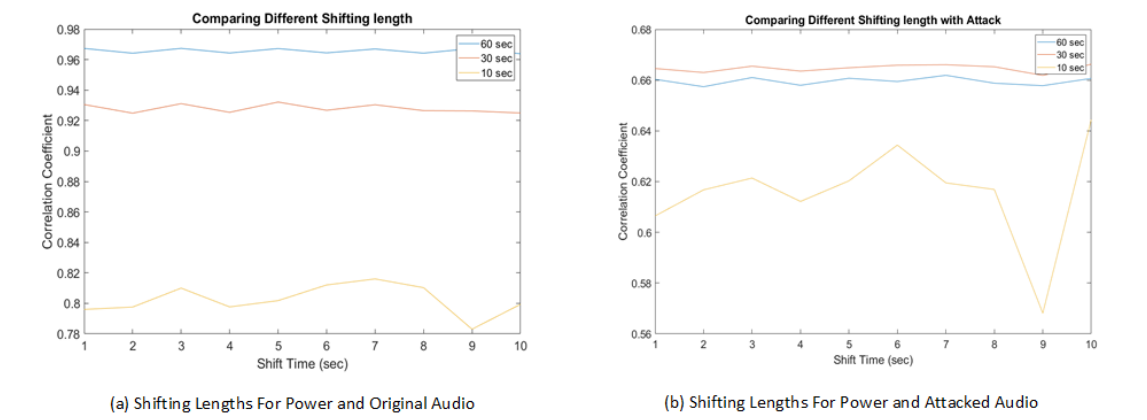
Figure 12. Shifting lengths comparing power with the original and attacked audio.